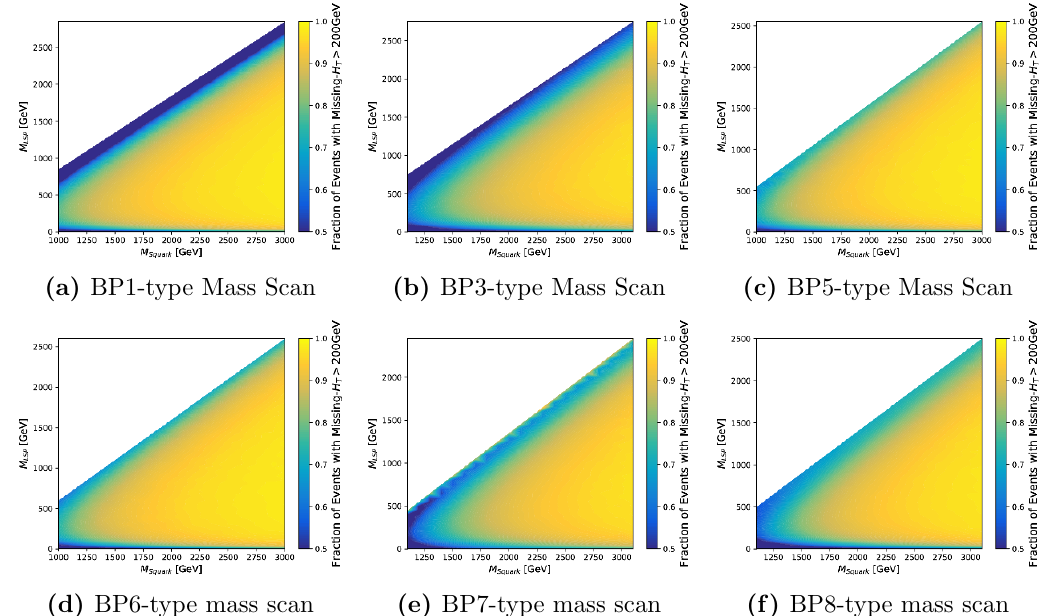
Figure 8. Fraction of events with H miss